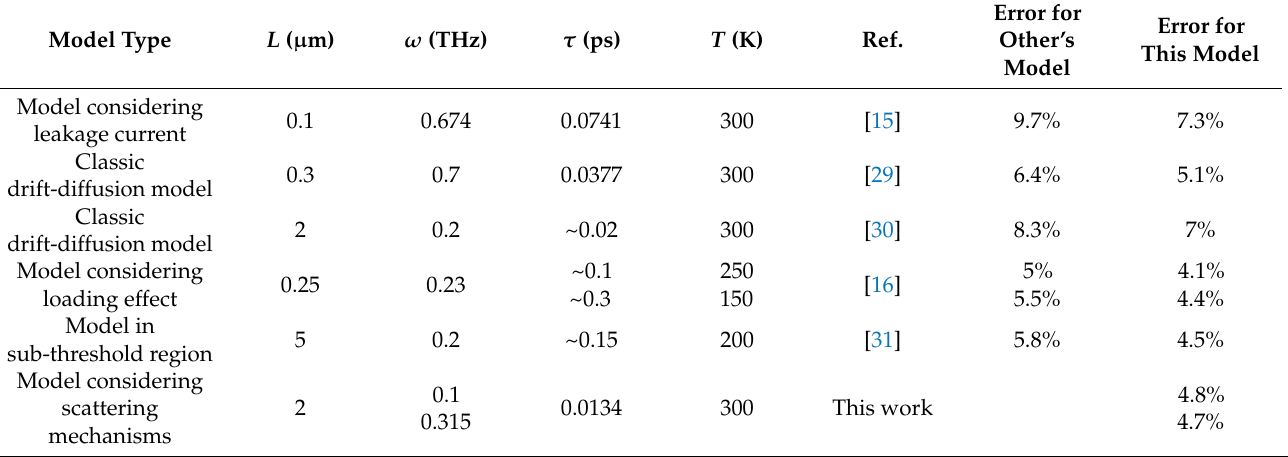
Table 3. Main material parameters and model